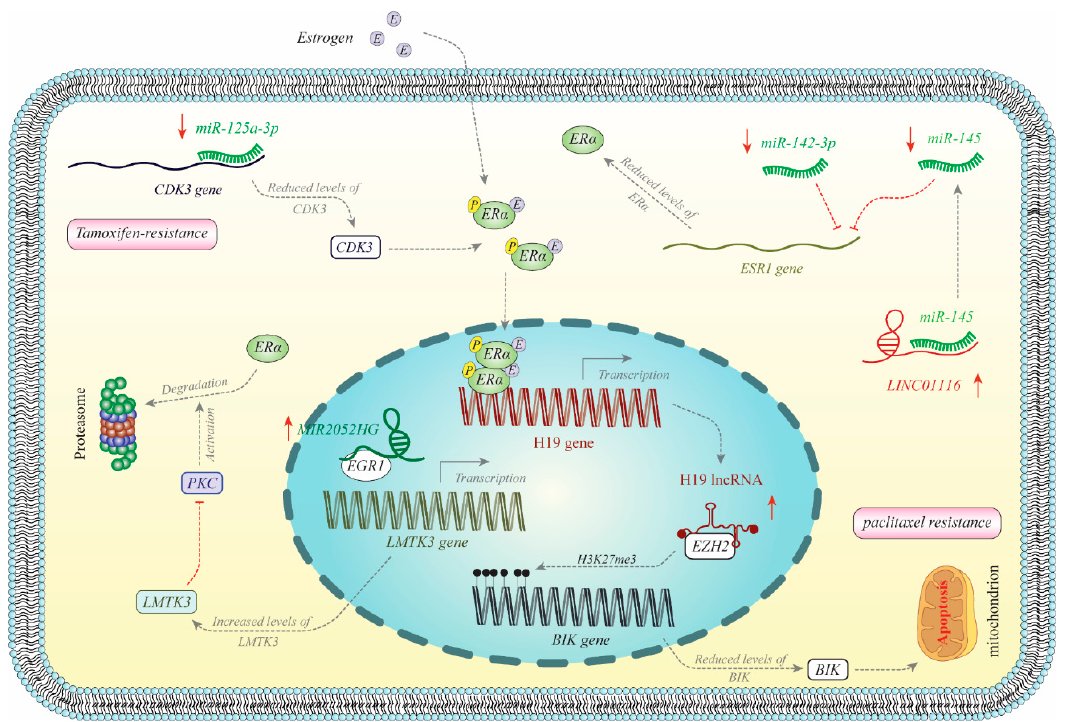
Figure 2. Schematic diagram illustrating mechanisms of noncoding RNA regulation of ER in breast cancer. Expression of miR-125a is increased in tamoxifen-resistant breast cancer cells. miR-125a binds to the 3 ′ UTR of CDK3 to inhibit its expression. CDK3 phosphorylates ER and increases its activity [78]. MIR2052HG is over-expressed in ER α -positive breast cancer cells. MIR2052HG facilitates binding of EGR1 with the promoter of the LMTK3 gene to enhance its expression. LMTK3 inhibits PKC and reduces ER degradation [45]. H19 is one the downstream targets of ER α . H19 is increased in ER α -positive breast cancer cells. H19 recruits EZH2 and enhances H3K27me3 of BIK promoter to reduce its expression, inhibit apoptosis and induce resistance to therapeutic options [30]. LINC01116 is increased in breast cancer tissues and acts as a sponge for miR-145, which binds with the 3 ′ UTR of ESR1 to inhibit its expression. Thus, over-expression of LINC01116 enhances ER levels [29]. miR-142-3p is downregulated in ER-positive breast cancer cells. This miRNA binds with 3 ′ UTR of ESR1 to inhibit its expression [65].